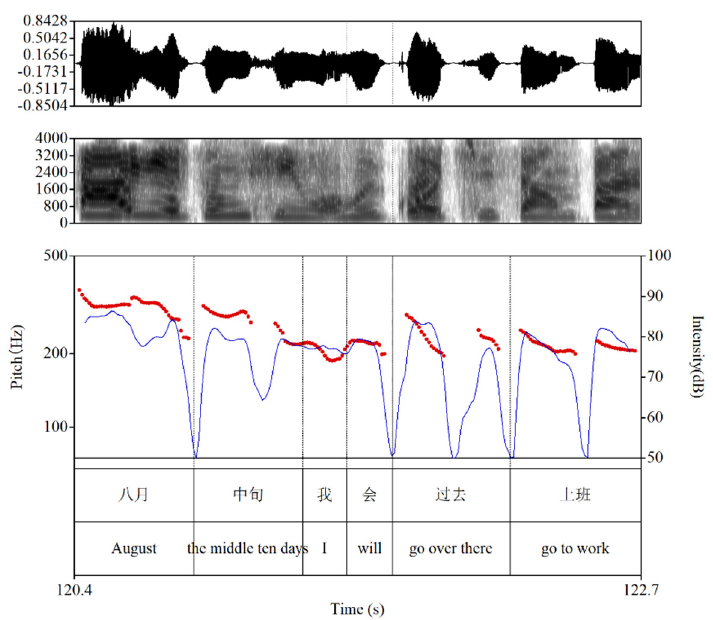
Figure 1. Waveform, spectrogram, pitch contour, and intensity of line 07. The red line represents the pitch contour, and the blue line represents the intensity contour.